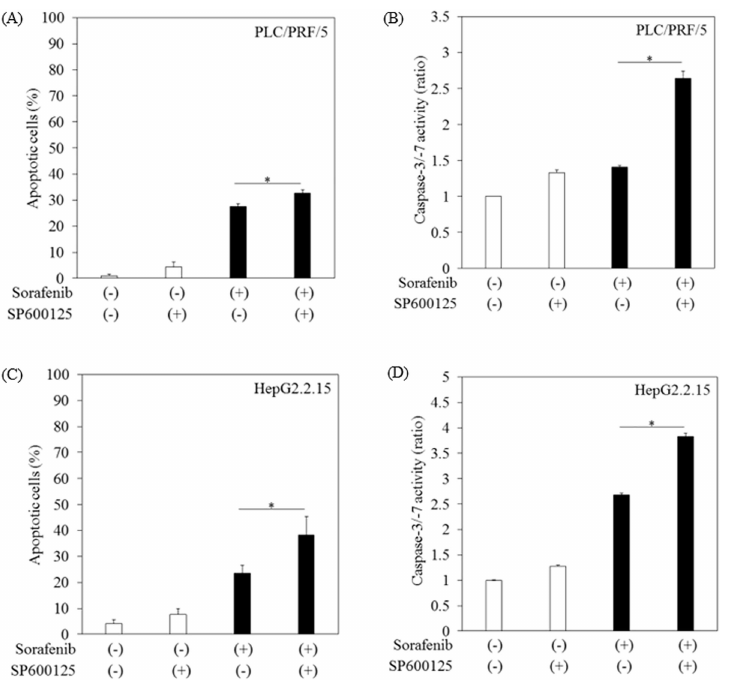
Fig 6. SP600125enhanced sorafenib-induced apoptosis in human hepatoma cell lines. (A, B) PLC/ RPF/5, (C, D) HepG2.2.15. Apoptosis in cells treated with or without 10 μ M sorafenibfor 12 hours after treatment with or without 45 μ M SP600125for 12 hours. (A, C) The numberof apoptoticcells was determined by APOPercentage apoptosisassay (Biocolor). (B, D) Caspase-3/-7 activity was measured by Caspase-Glo 3/7 assay (Promega). Data are presented as mean ± SD of triplicate samples. * p < 0 . 05 betweentwo